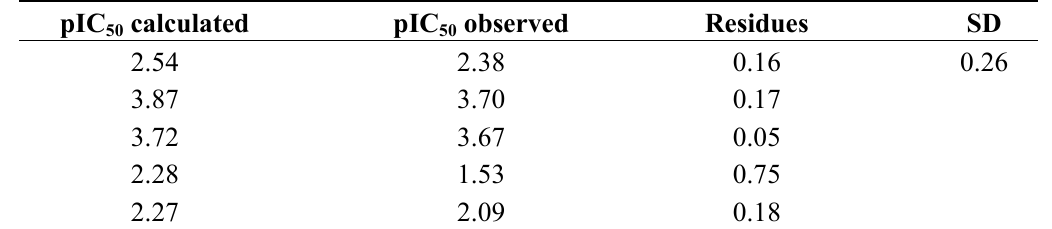
values, residues and standard deviation (SD) of the mean of the residues of Table 6. pIC 50 the tested series.